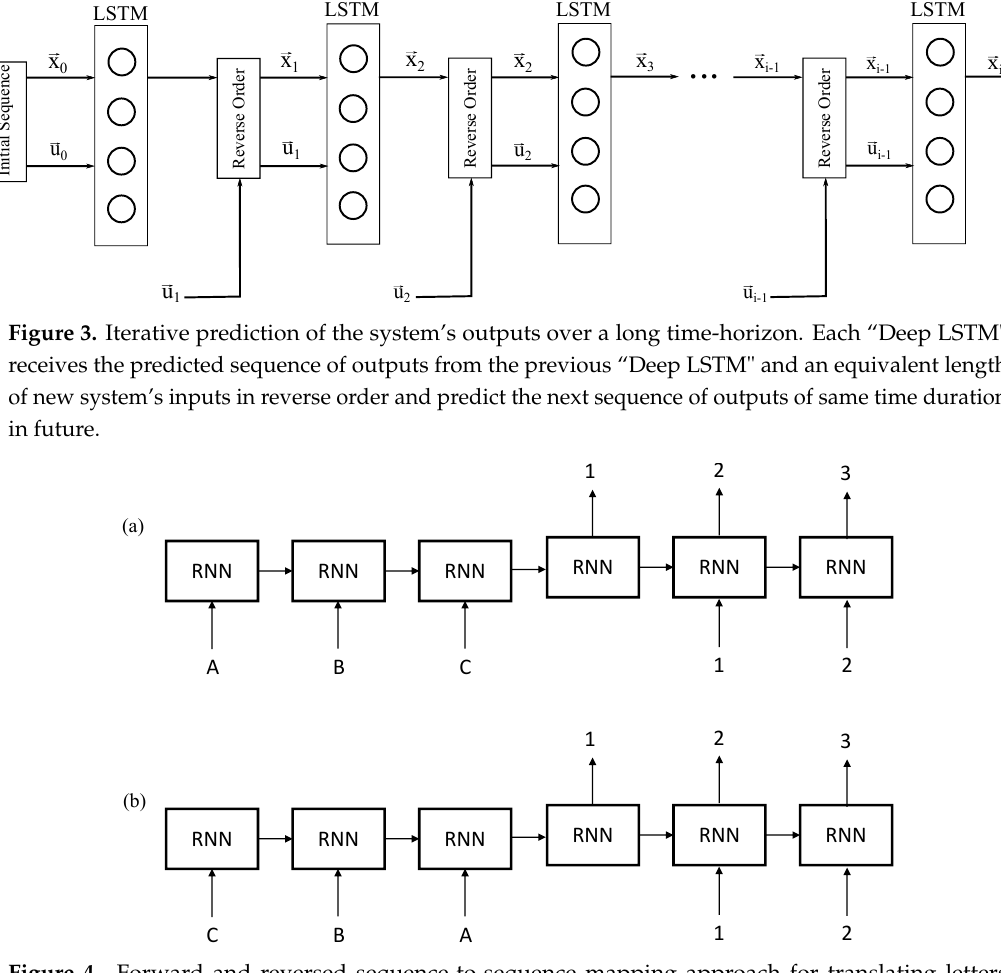
Figure 4. Forward and reversed sequence-to-sequence mapping approach for translating letters (inputs) to their numerical indices (outputs) in recurrent neural network (RNN). ( a ) shows the forward sequence-to-sequence mapping approach. The input is fed into the network in the same sequence as the desired output. The “distance” between all corresponding inputs and outputs is uniform. ( b ) shows the reversed sequence-to-sequence mapping approach. This approach introduces a temporal symmetry between input and output sequences while keeping the average “distance” between the corresponding inputs and outputs same as the forward approach. As shown in ( b ), A → 1 is the shortest “distance" to map, B → 2 the second, and C → 3 the